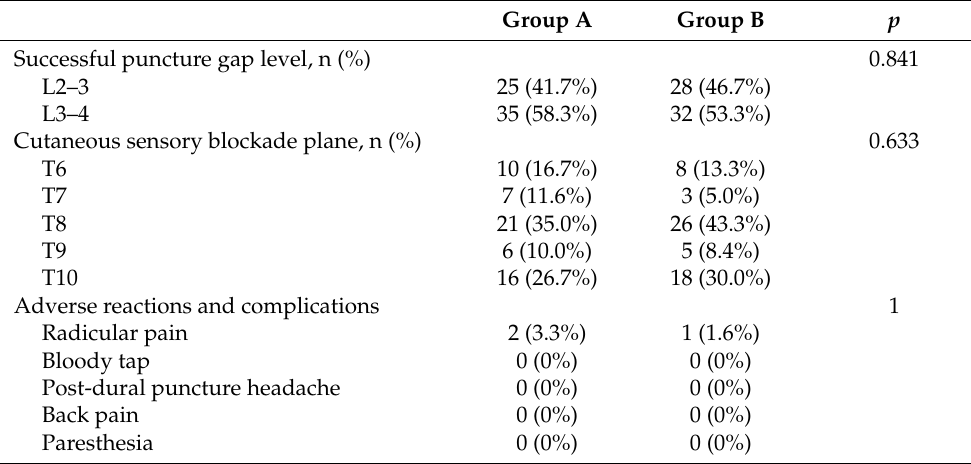
Table 3. Block characteristics and adverse reactions.